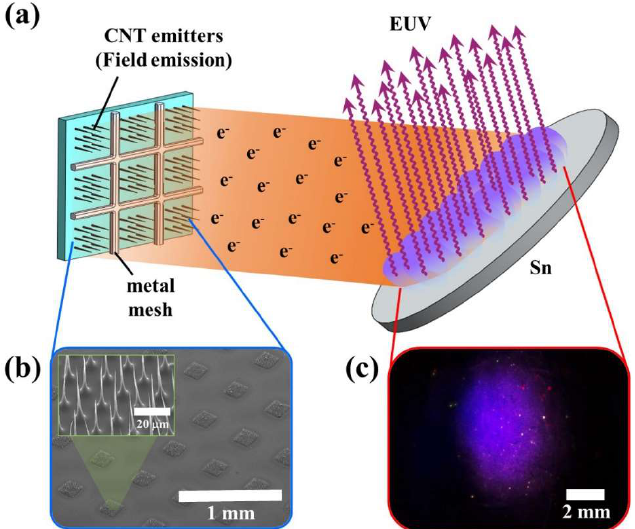
Figure 1. Schematic for extreme ultraviolet lighting with carbon nanotube-based cold cathode electron beam. ( a ) Configuration for extreme ultraviolet generation. ( b ) Scanning electron microscope image of carbon nanotube emitters. ( c ) Photo image of Sn surface.